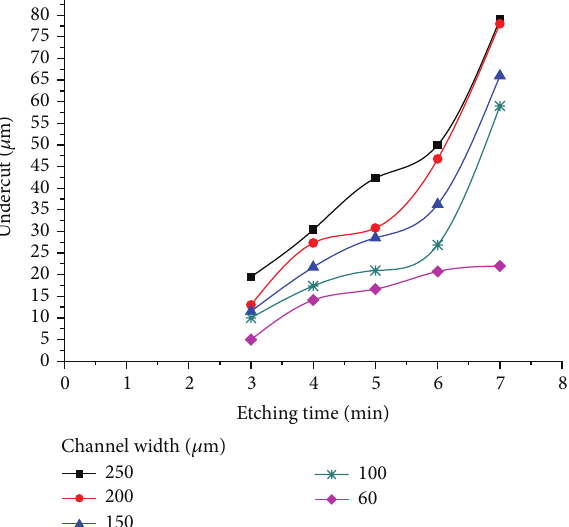
Figure 9: Effect of etching time on undercut for different channel